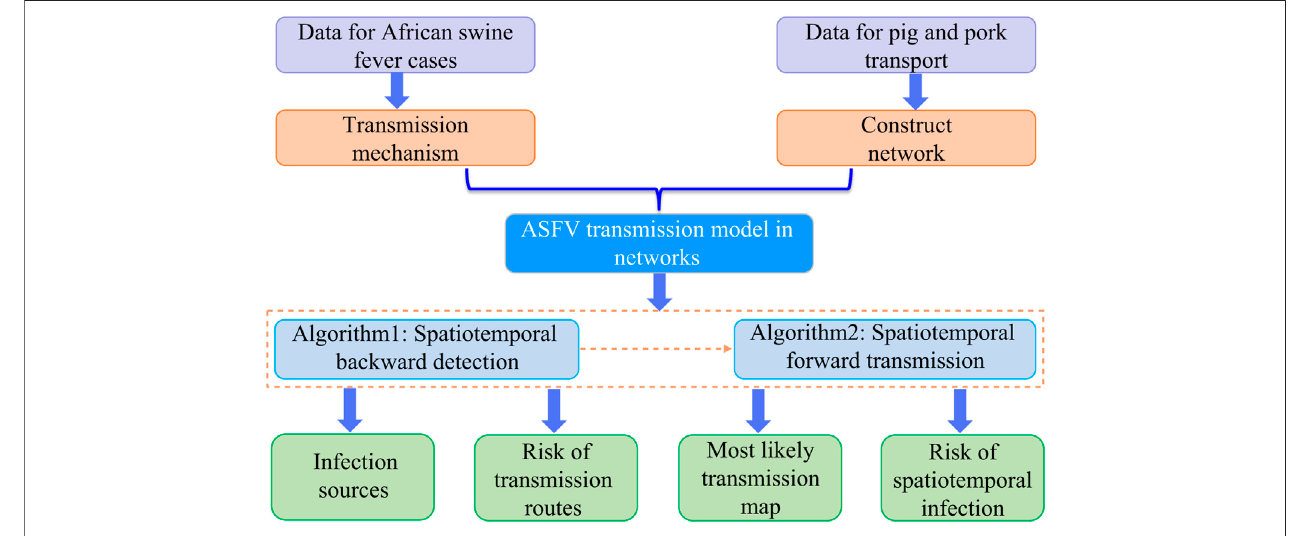
FIGURE 1 | Overview of the proposed framework in the